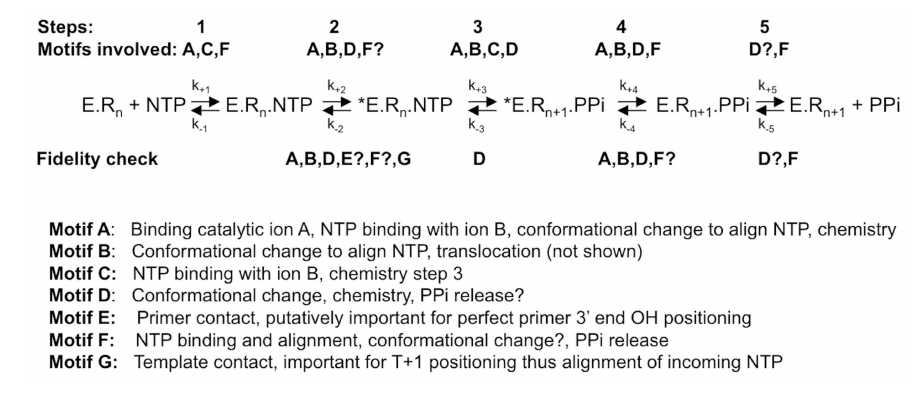
Figure 7. Current model of the involvement of catalytic and structural motifs of Flavivirus RdRps in NTP incorporation into RNA and RNA synthesis fidelity. Above the reaction scheme